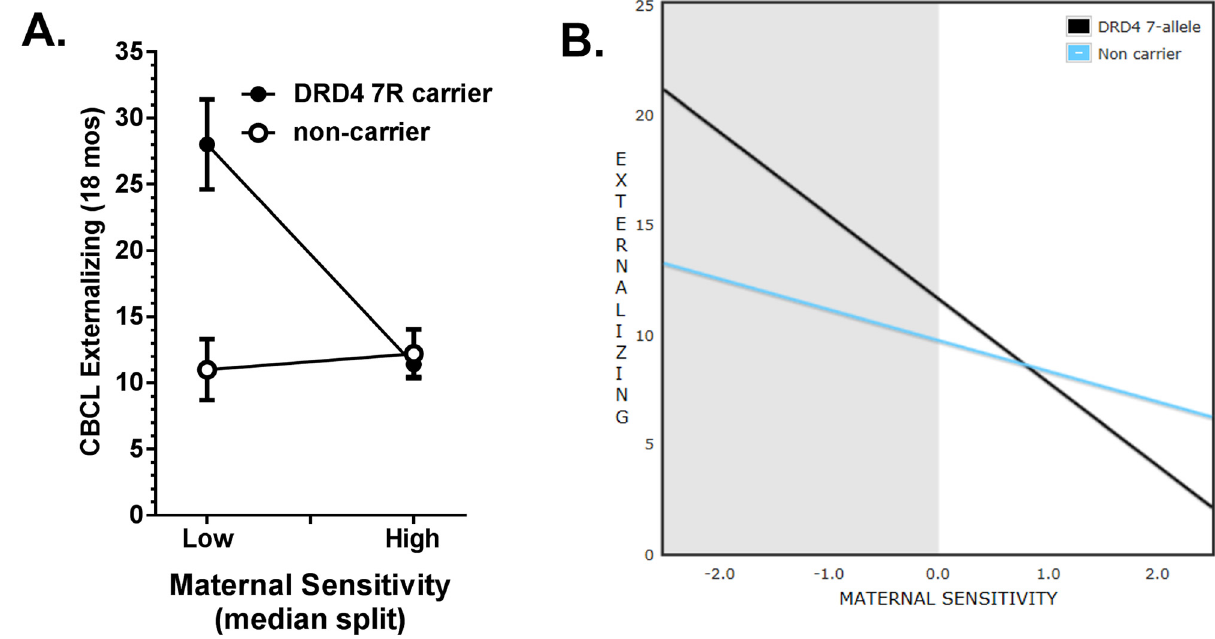
Fig 1. Interactive effect of DRD4 genotype and maternal sensitivity at 6 months predicting externalizing behaviors at 18 months. A. CBCL Externalizing behaviors for European-ancestry toddlers at 18 months. DRD4 7R carriers or non-carriers, with mothers with high or low sensitivity (median split) at 6 months. B. Linear regression slopes of CBCL Externalizing behaviors at 18 months by Maternal Sensitivity at 6 months are depicted separately for 7R-allele carriers and non-carriers, controlled for maternal age, child sex, child ancestry, and maternal depression. Regions of significance (RoS) are highlighted in the graph (shaded area). Only the lower bound of Maternal Sensitivity falls within the RoS (i.e. significant DRD4 differences in child externalizing behaviors are not seen in children with mothers expressing high sensitivity) consistent with a diathesis-stress